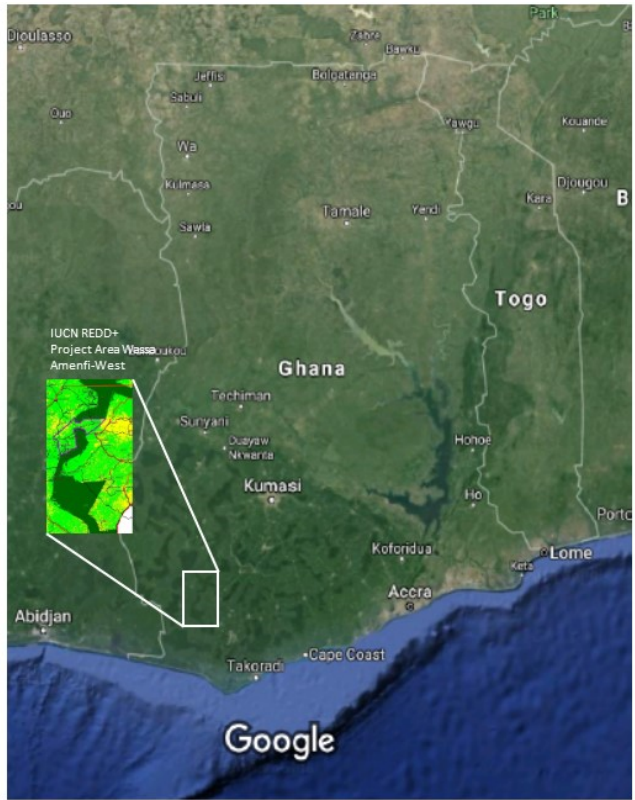
Figure 1. Map with main research area in SW Ghana highlighted.